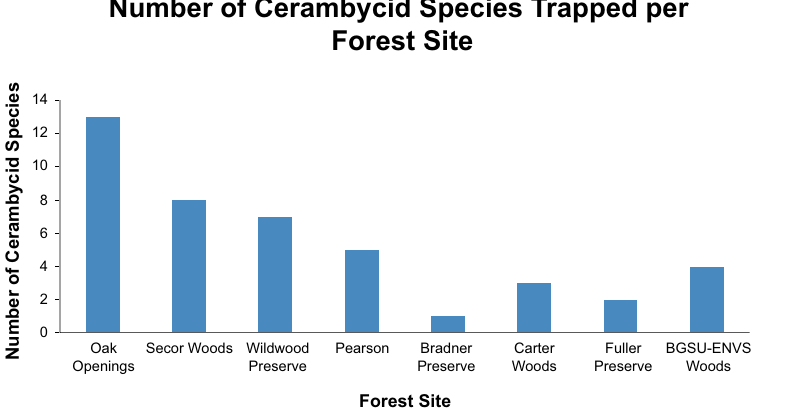
Figure 6. Total number of Cerambycid species caught in each forest during 2008. Oak Openings, Secor, Wildwood, and Pearson were the Large Forests, and Bradner Preserve, Carter Woods, Fuller Preserve, and ENVS Woods were the small forests.